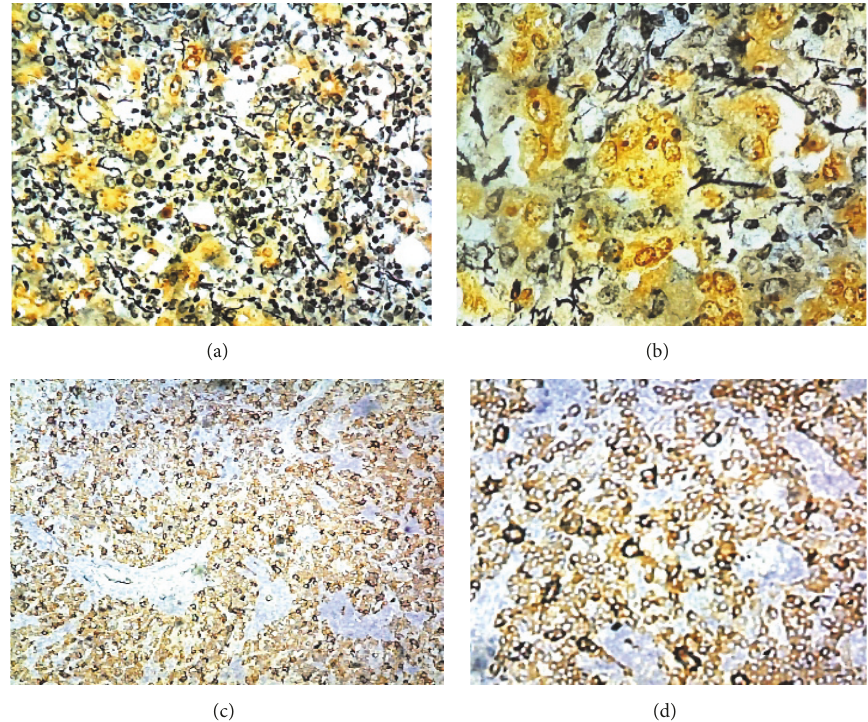
Figure 5: (a) Argyrophilic reticular network interrupted ( Gomori 100x ); (b) Gomori ( 400x ); (c-d) Cytokeratin AE1-AE3—it is recognizable, though the trabecular architecture is altered ((c) 100x, (d) 200x